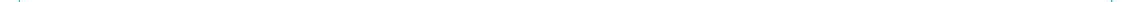
Figure 1: Diagram of the four-state Markov model used to predict the distribution of anaesthesiologists. The four states of the model repre- sent the different possible positions of anaesthesiologists during their careers in Switzerland. Training includes the period between